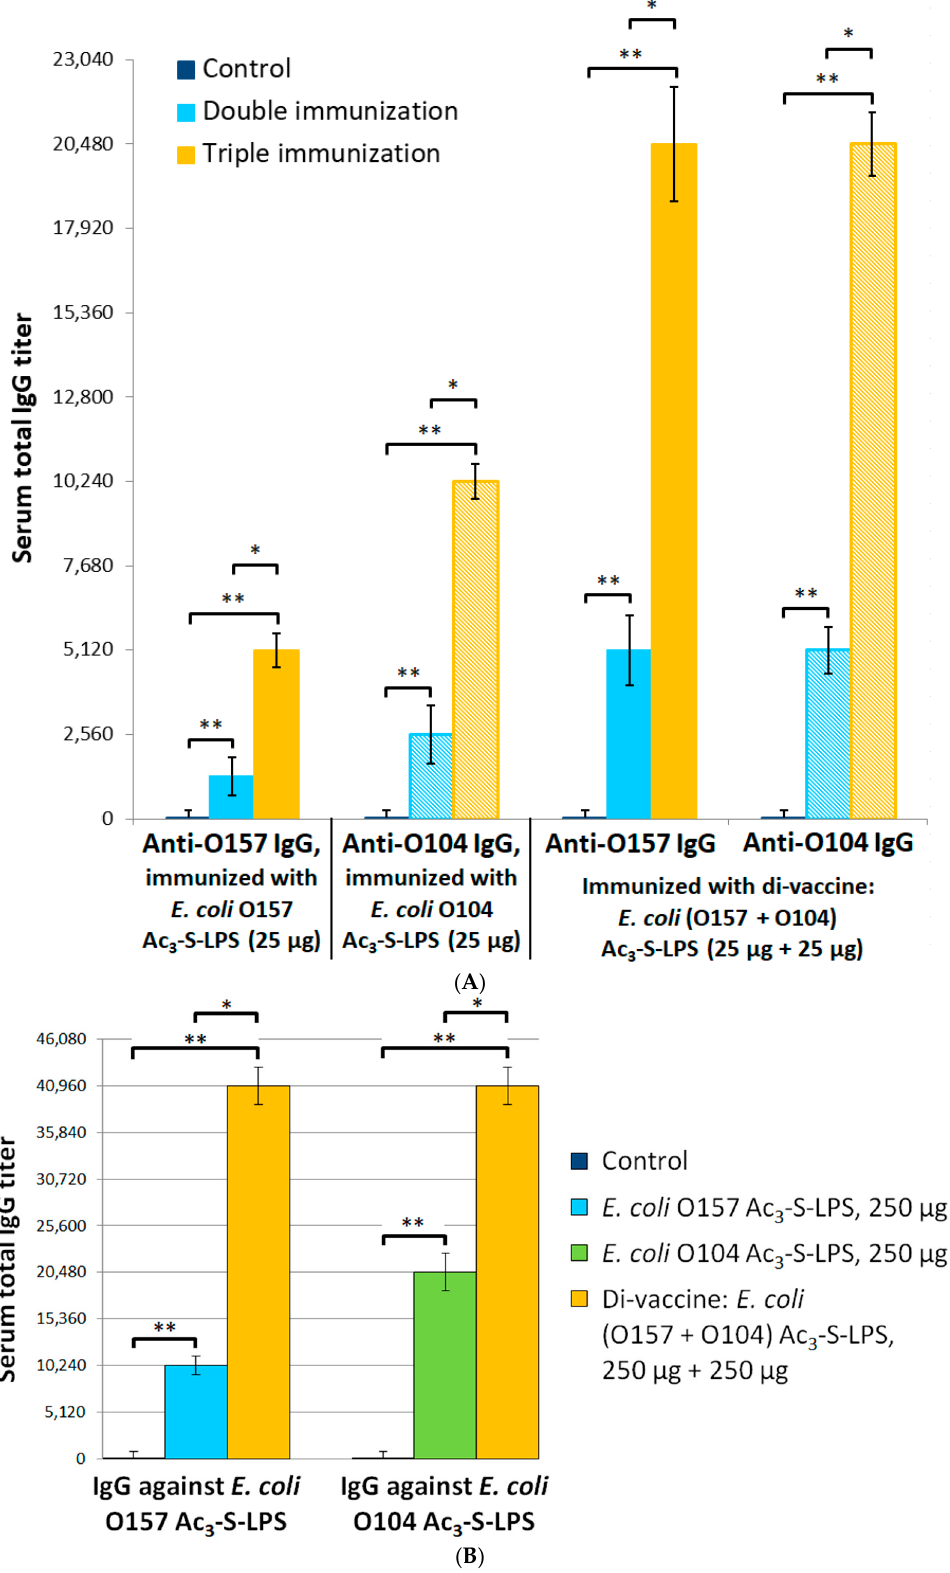
Figure 4. Total IgG serum antibody response in mice induced by E. coli (O157 + O104) Ac 3 -S-LPS di-vaccine and its individual components. ( A ) Mice were immunized i.p. two or three times with 25 µg of each Ac 3 -S-LPS E. coli O157 or Ac 3 -S-LPS E. coli O104 antigen or with 50 µg (25 µg + 25 µg) of di-vaccine. The third injection of preparations elicited increases in titers over those following the second injection, and these rises were significant ( p < 0.05, ANOVA). The highest levels of serum